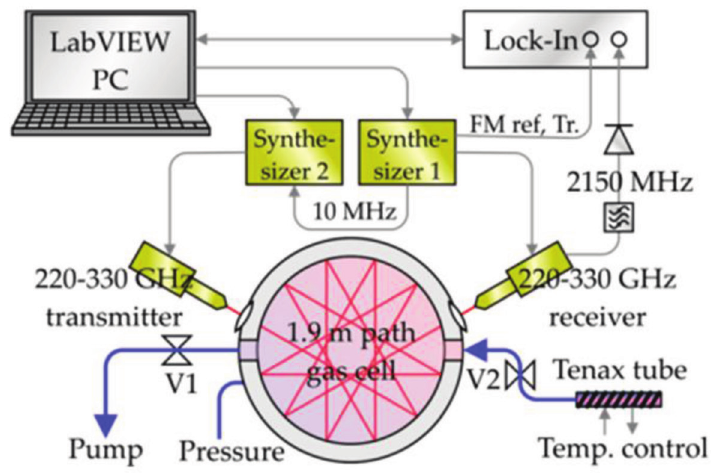
Figure 10: Setup of the mm/THz gas spectrometer for breath analysis. Reprinted from Ref.